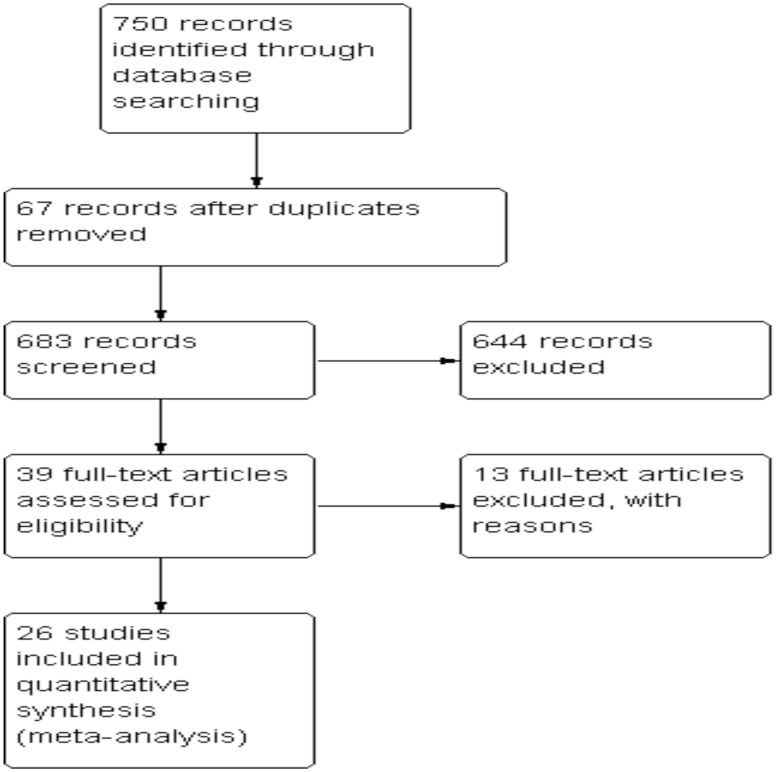
Flow diagram indicating the study selection.